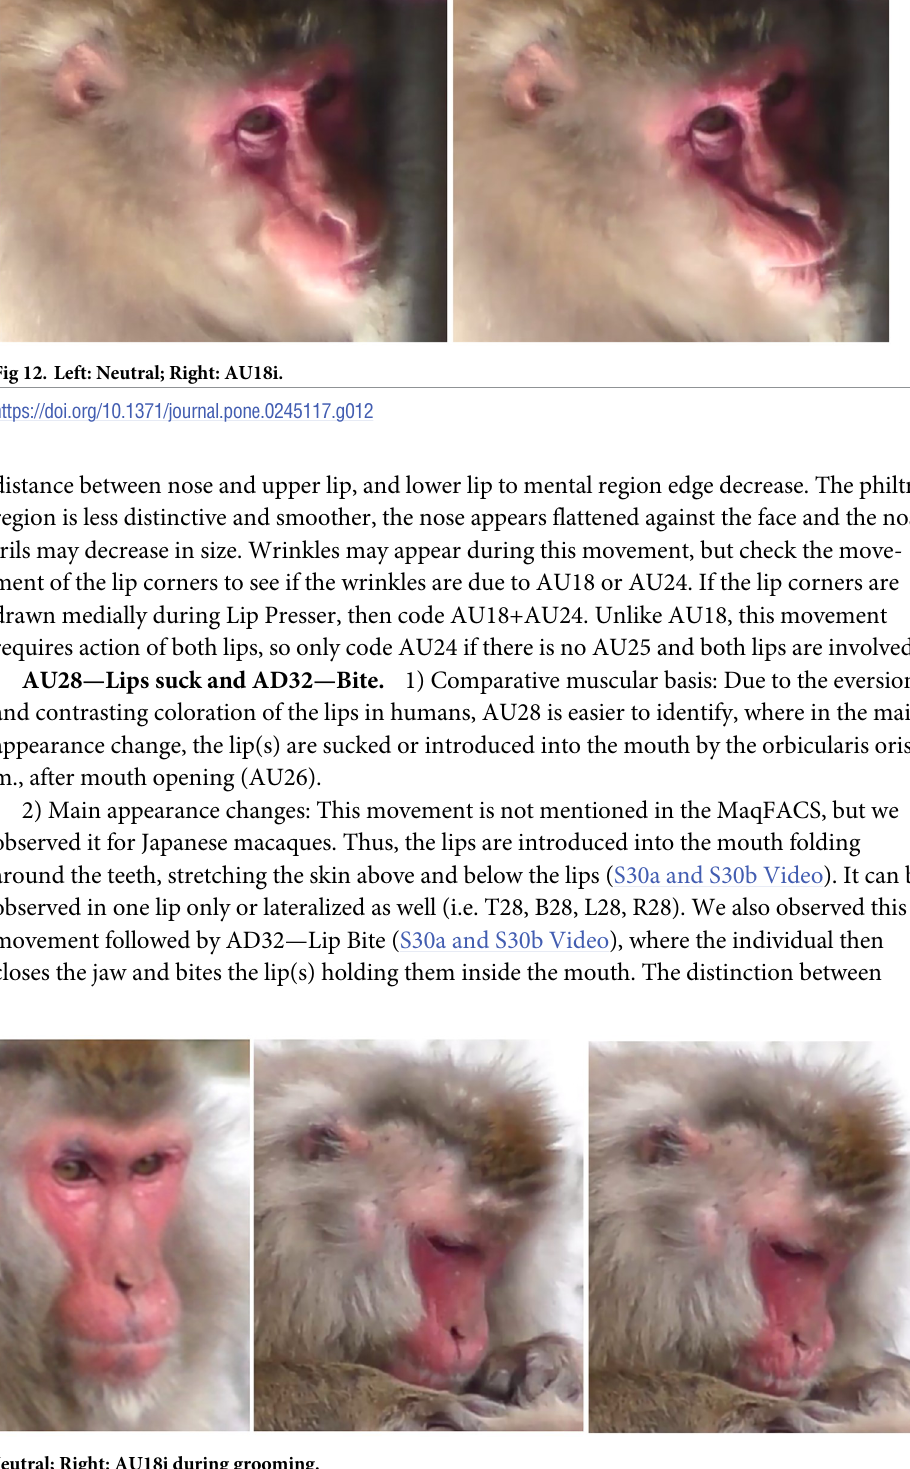
Fig 13. Left: Neutral; Right: AU18i during